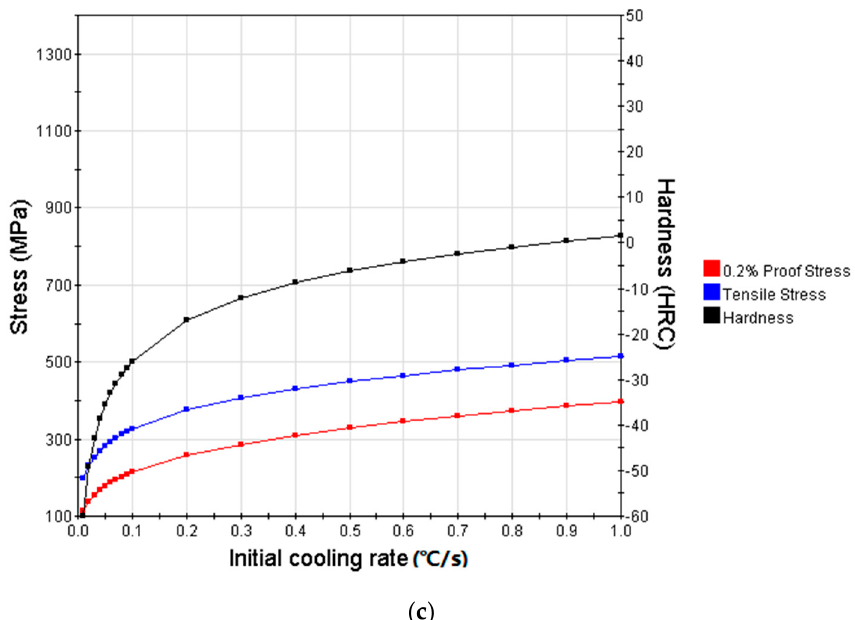
Figure 4. Result of analysis of solidification phases and properties: tensile stress (MPa)/0.2% proof stress (MPa)/hardness (HRC)–initial cooling rate ( °C /s): ( a ) initial cooling rate 100 °C /s; ( b ) initial cooling rate 10 °C /s; ( c ) initial cooling rate 1 °C /s.